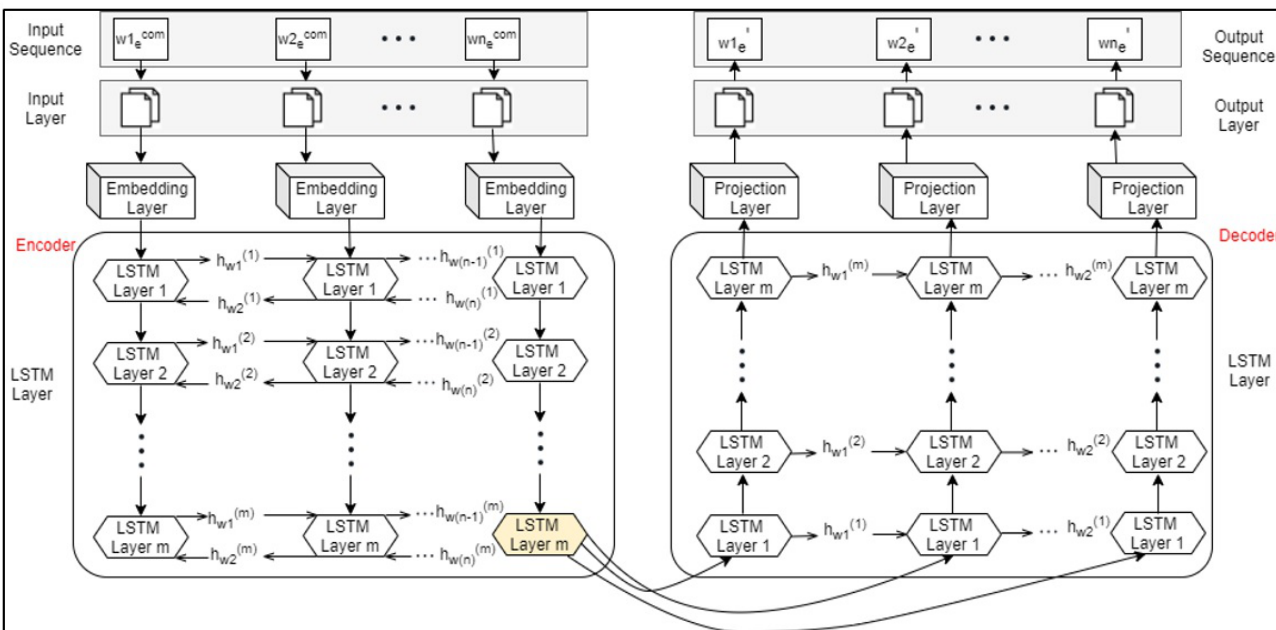
Figure 6. AFED model with a bidirectional LSTM encoder and unidirectional LSTM decoder. We establish the “gold standard" decoder output based on the alignments which intend to copy as many input characters as possible to the output while increasing the input cursor and producing new symbols only as the last option. AFED provided state-of-the-art performance. The whole experimentation model is shown in Figure 7.